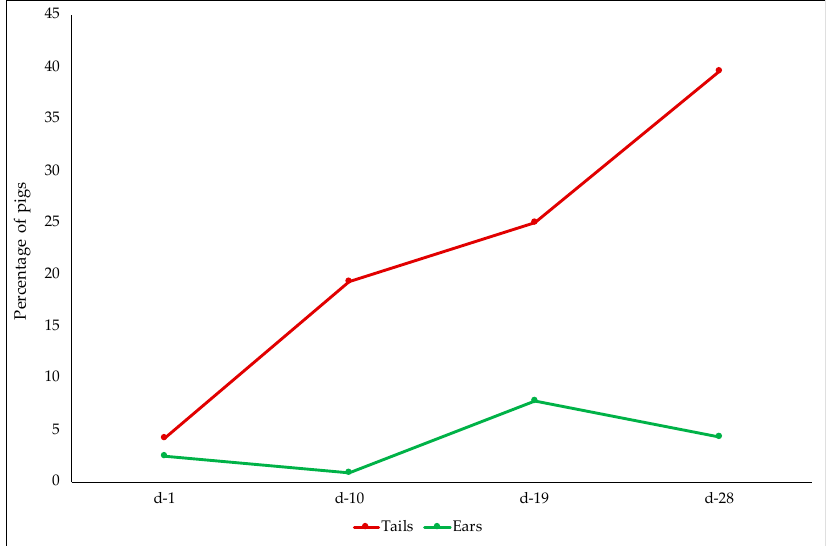
Figure 4. Percentage of pigs with tail and ear lesions at different times of recording.